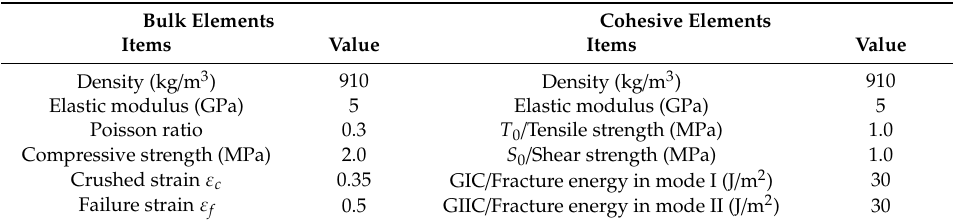
Figure 6. The model and mesh division of the ice block. Table 2. The material parameters of ice bulk elements and cohesive elements.